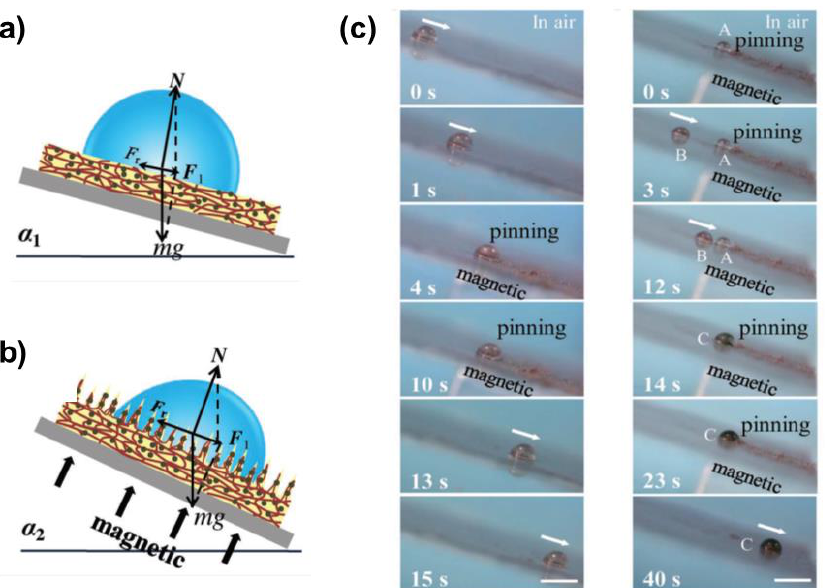
Figure 7 . Scheme of a droplet’s force analysis before ( a ) and after ( b ) applying a magnetic field. N, F r , g, m, and F 1 is the positive direction force refers to the normal force, surface retention force resulting from contact angle hysteresis (CAH), the mass of the droplet, the gravitational acceleration constant, and the resultant force of mg and N, respectively. ( c ) Droplet motion control on slippery gel surface and demonstration of the magnetically controlled liquid droplet transport for a chemical reaction. Reproduced with permission [46]. Copyright 2019, Wiley-VCH.